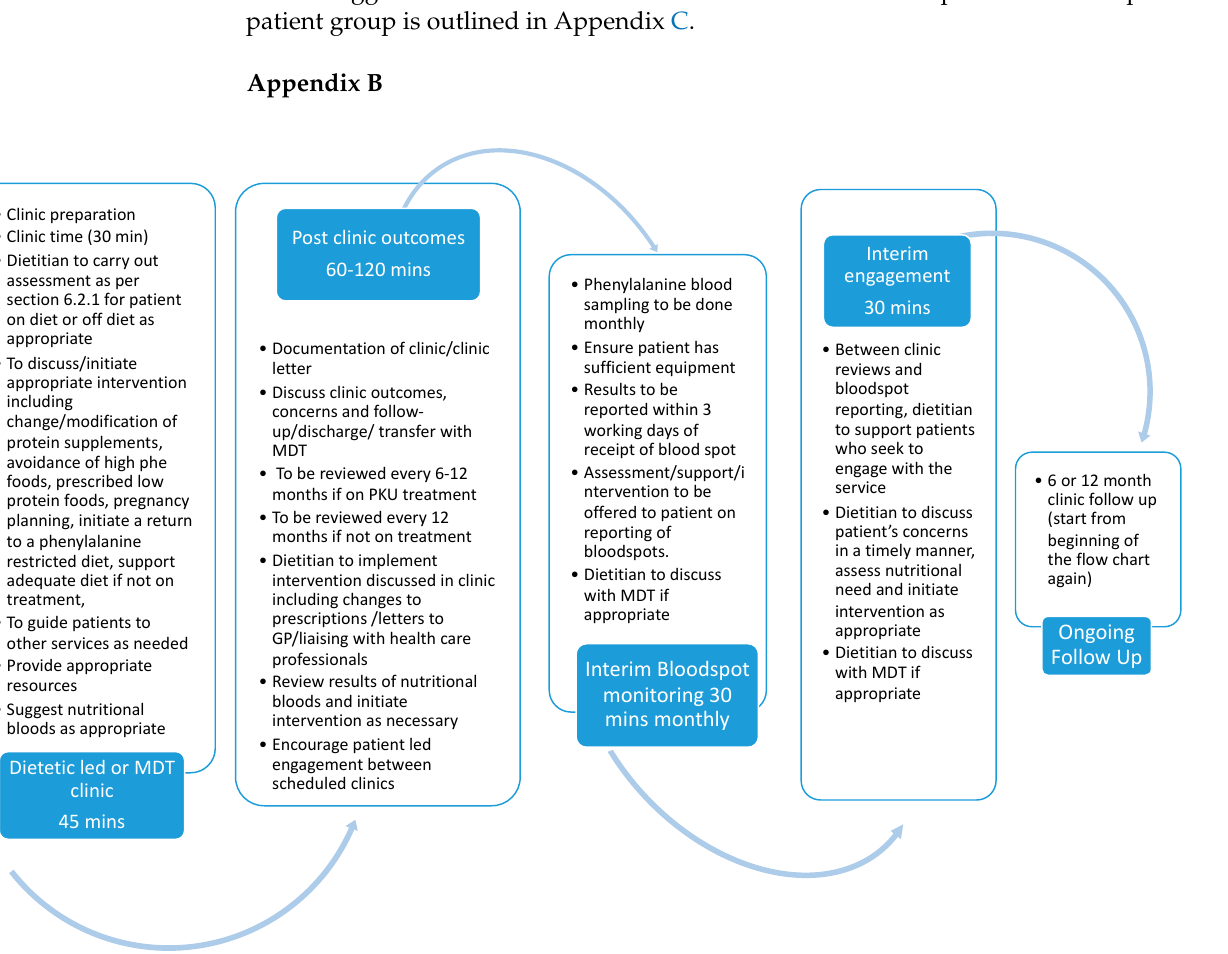
Table A1. Suggested Audit tool for the SOP .